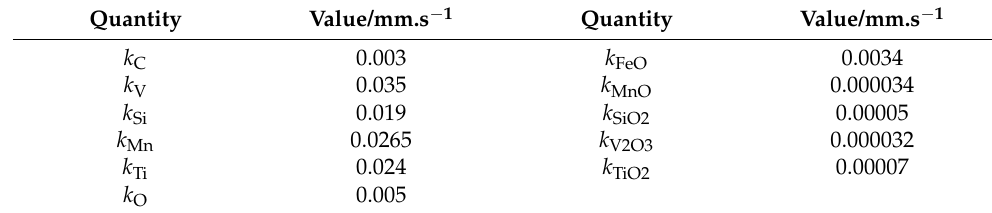
Table 3. Mass transfer coefficient in metal and